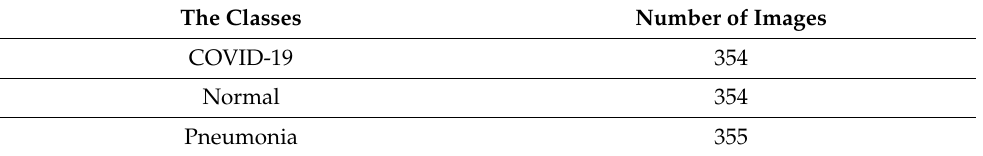
Table 2. Numerical description of the prepared dataset for three-class classifier.